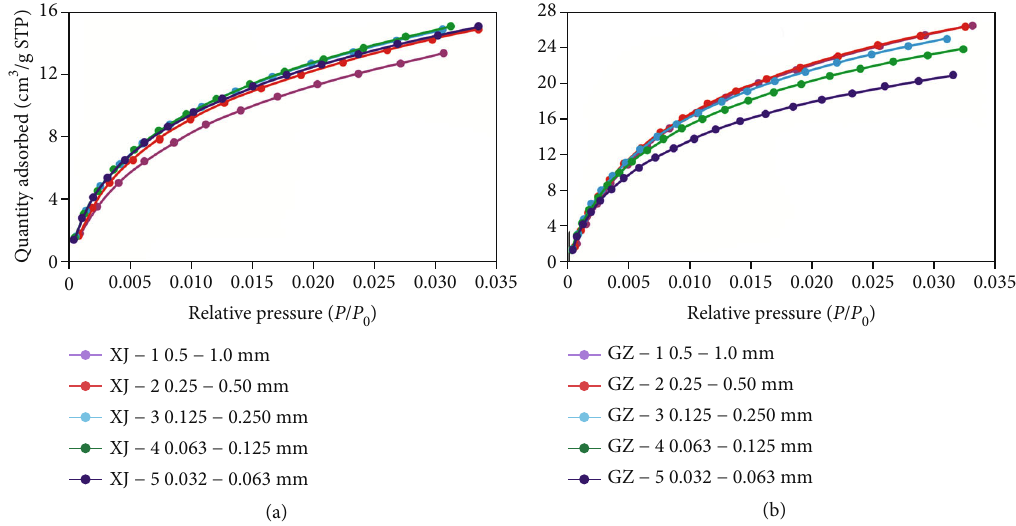
Figure 5: Pore size distributions of the coal subsamples with di ff erent particle sizes using low-pressure N (XJ-01 to XJ-05 represent Coal XJ with particle size from 0.5-1.0mm to 0.032-0.063mm). (b) Coal GZ (GZ-01 to GZ-05 represent Coal GZ with particle size from 0.5-1.0mm to 0.032-0.063mm).